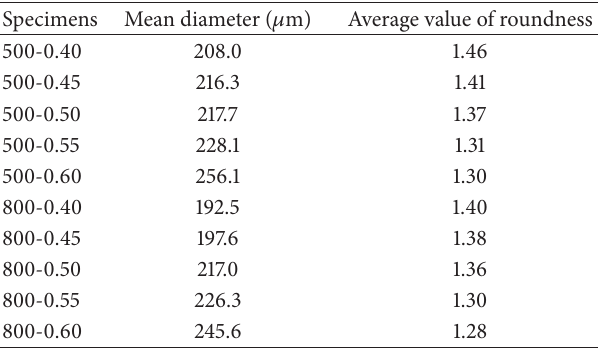
Table 4: Characteristics of air pores of the test